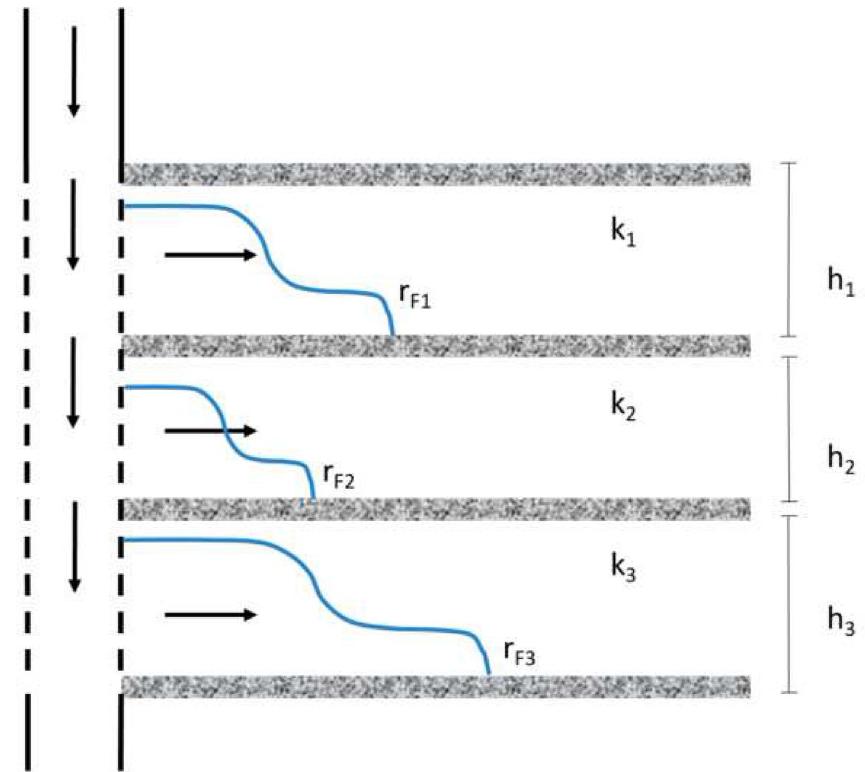
Fig. 3 Waterfront propagation in each